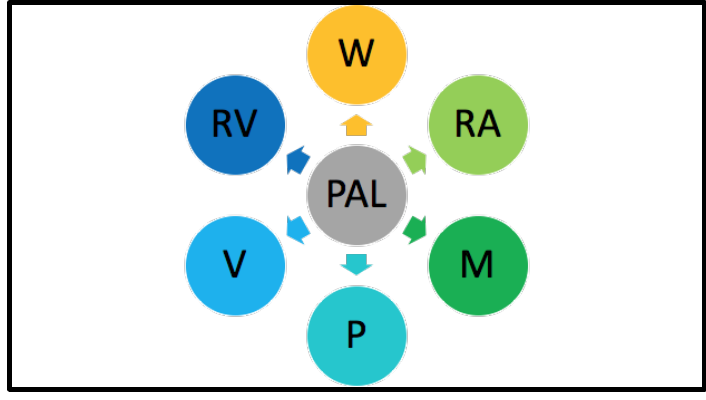
Figure 1. PAL course attribute supporting all six course delivery